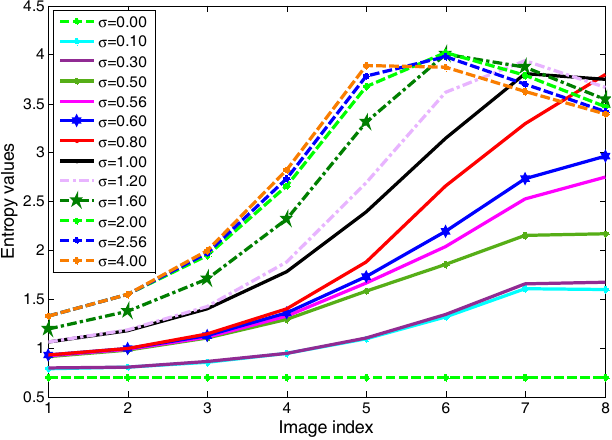
Figure 7. The entropy values of the eight images using different standard deviations σ .